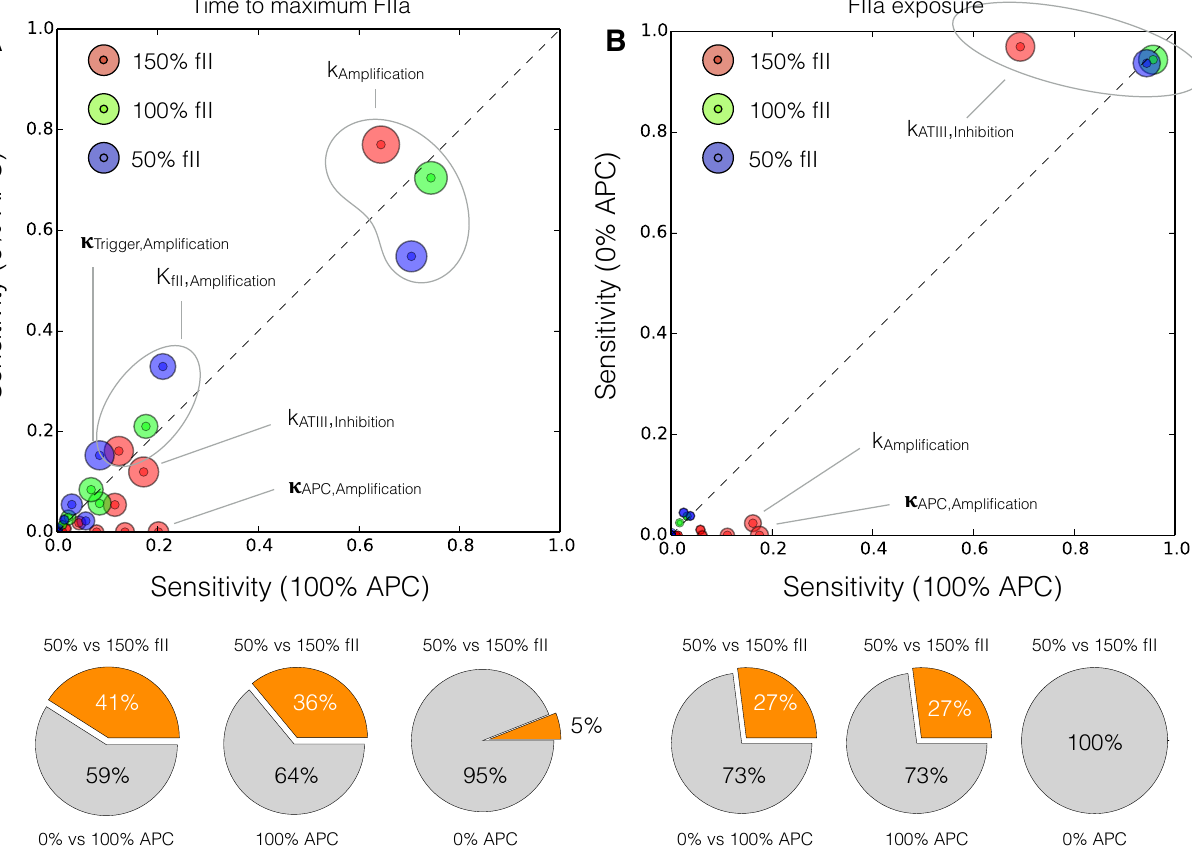
Figure 9. Global sensitivity analysis of the reduced order coagulation model with respect to the model parameters. ( A ) Sensitivity analysis of the thrombin peak time for different prothrombin levels (150%, 100% and 50% of the physiological value) as a function of activated protein C; ( B ) Sensitivity analysis of the thrombin exposure for different prothrombin levels (150%, 100% and 50% of the physiological value) as a function of activated protein C. Points denote the mean total sensitivity value, while the area around each point denotes the uncertainty in the sensitivity value. The gray dashed line denotes the 45 ◦ degree diagonal, if sensitivity values are equal for different conditions they will lie on the diagonal. Sensitivity values significantly above or below the diagonal indicate differentially important model parameters. The radius of the shaded region around each total sensitivity value was the maximum uncertainty in that value estimated by the Sobol